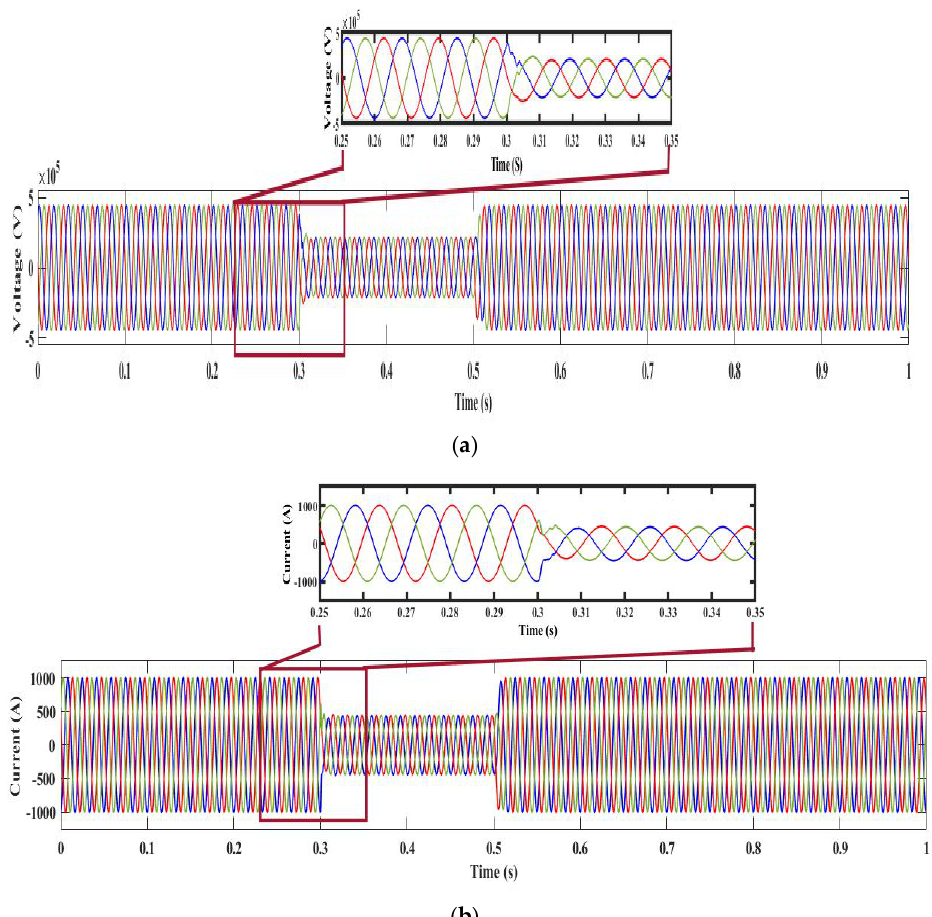
Figure 9. Analysis of ( a ) Bus 8 voltage and ( b ) Bus 8 current under power swing conditions.